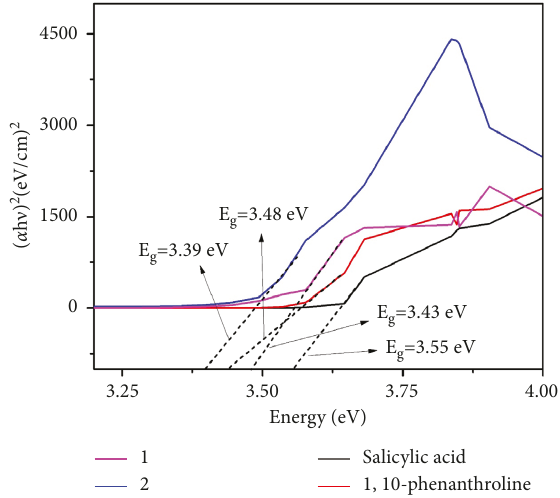
Figure 3: Tauc’s plots of salicylic acid, 1,10-phenanthroline, complex (1) and (2) for the estimation of band gap